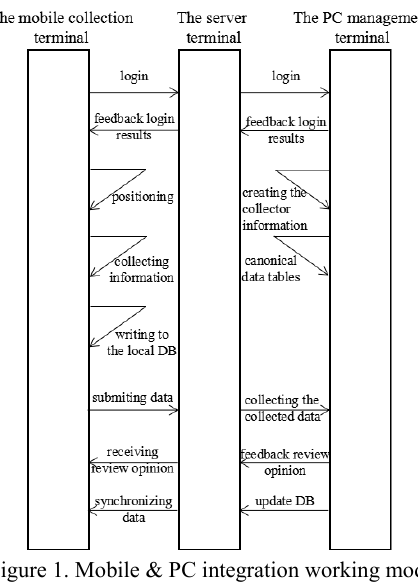
Figure 1. Mobile & PC integration working mode